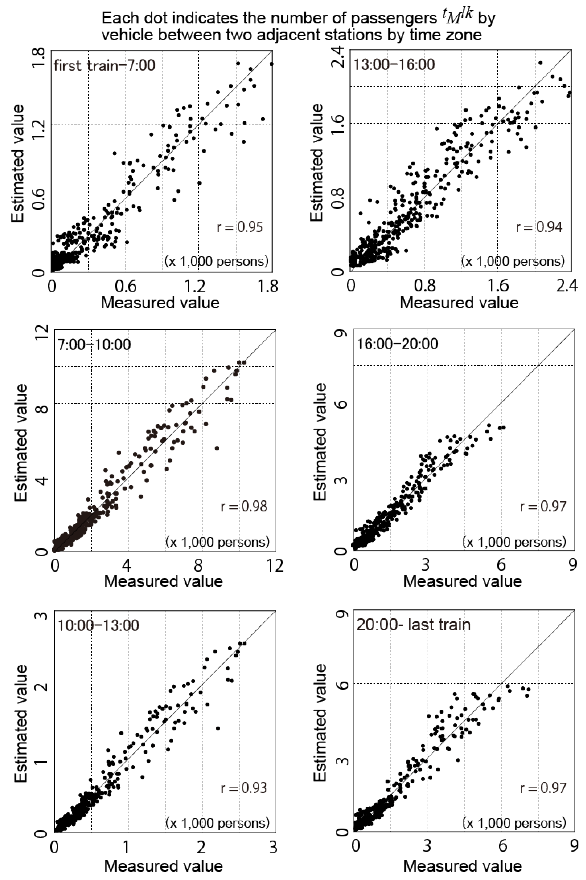
Figure 3 . Example of the correlation coefficients and correlation charts for the estimated t M lk and measured t M lk *